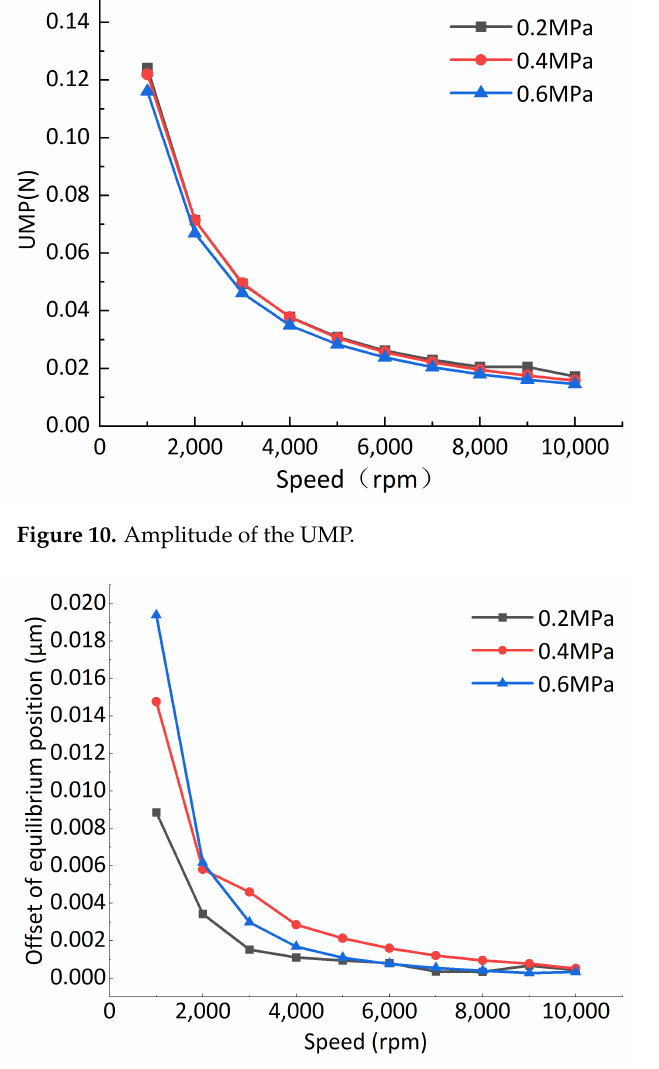
Figure 11. Offset of rotor equilibrium position caused by the